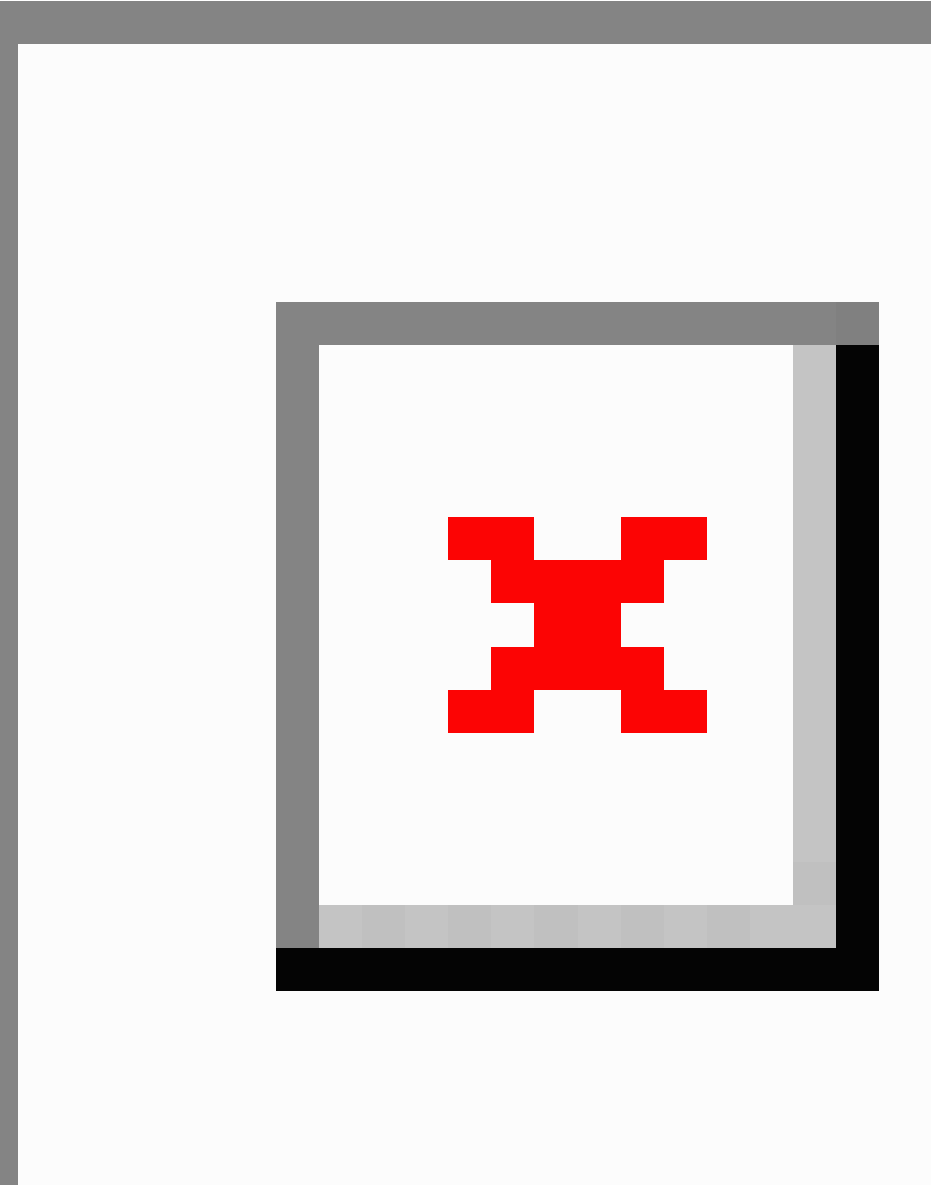
Figure 6. Comparison on 10 pictograms between our study and the Hong Kong study.